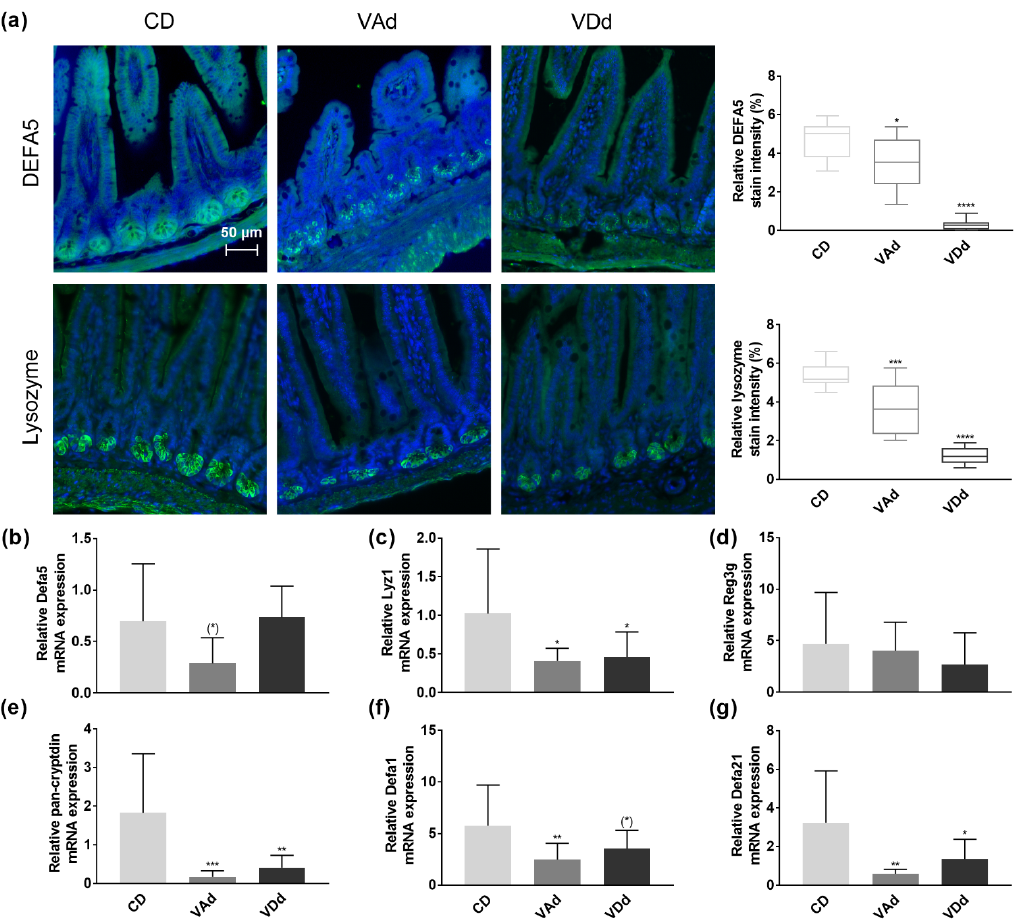
Figure 2. Vitamin A- and D-deficient diets disturb intestinal Paneth cell antimicrobials. Representative images showing DEFA5 or lysozyme expression in green and cell nuclei detected by DAPI in blue. Scale bar: 50 µ m. Quantification of relative DEFA5 and lysozyme fluorescence intensity in percent ( a